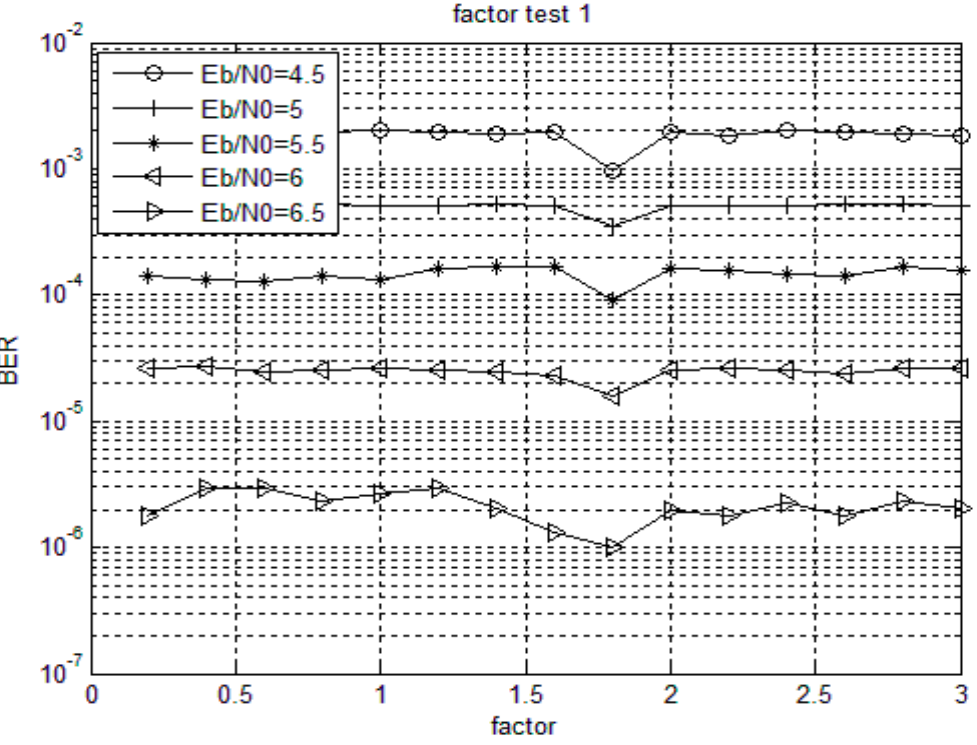
Figure 3. Code 1 weighted factor test.